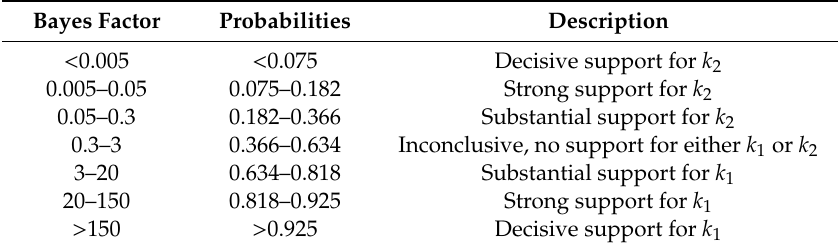
Table 1. Interpretation of level of support for model k 1 or k 2 from Bayes factors as defined in Equation (4), with k 1 in the numerator and k 2 in the denominator. When the probability of k 1 and k 2 is 1, the ranges of Bayes factor correspond to the probabilities in the “Probabilities”